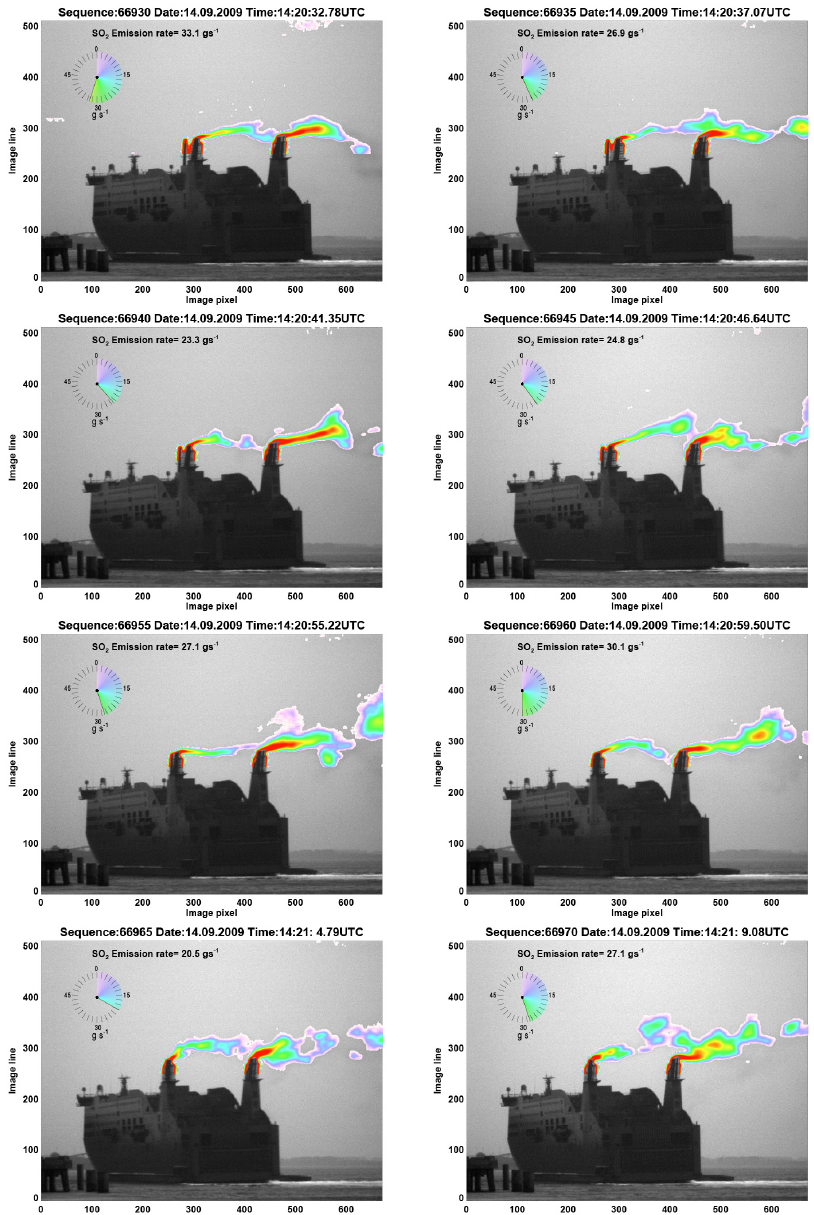
Fig. 16. Emission rate estimates from the UV camera or the Stena Hollandica manoeuvring at dock on 14 September 2009. Images are between 5–10s apart from a sequence acquired at 1s